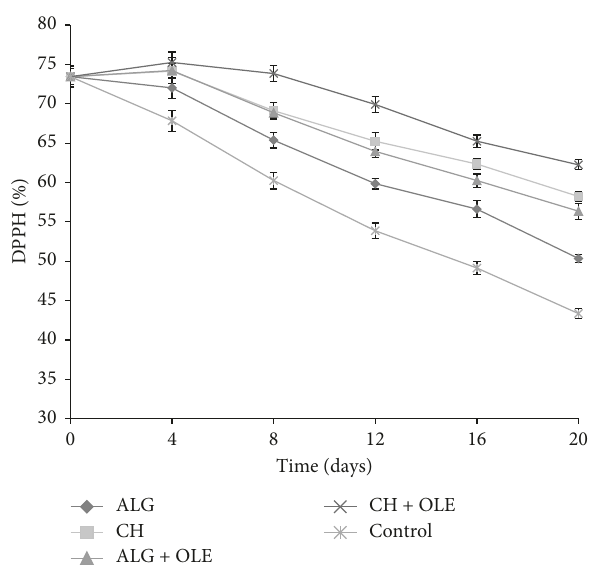
Figure 4: Changes in antioxidant activity expressed as the per- centage inhibition of DPPH radical. ALG: 3% alginate, CH: 1% chitosan, ALG +OLE: 3% alginate+ 1% olive leaves extract (OLE), CH +OLE: 1% chitosan+1% OLE, and control: distilled water.